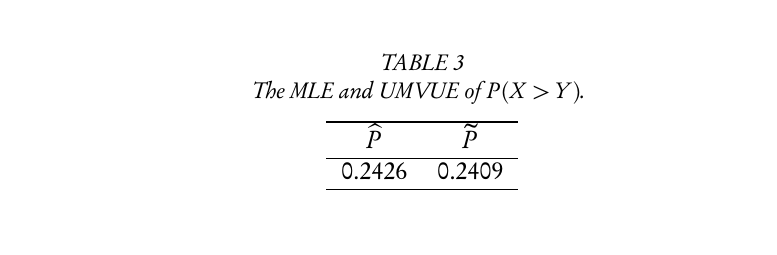
The MLE and UMVUE of P ( X > Y )